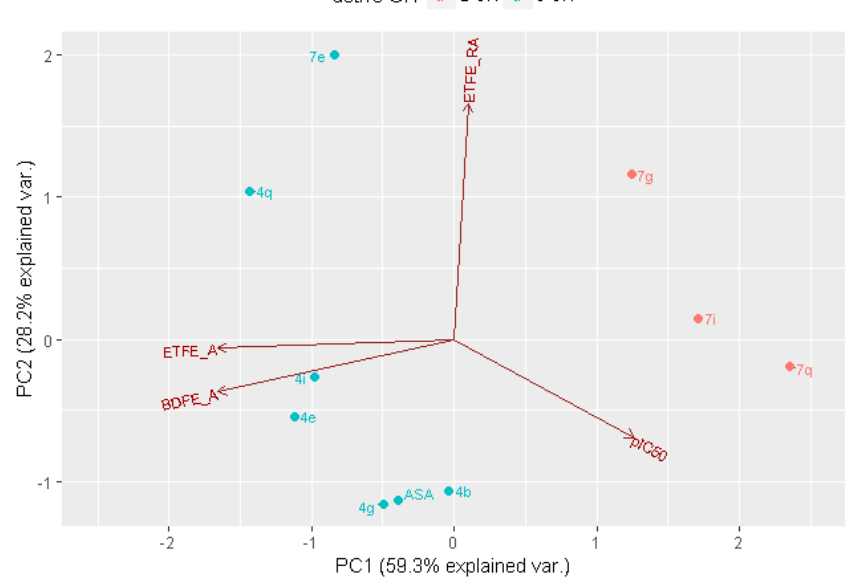
Figure 3. Principal component analysis (PCA) biplot for derivatives containing C4C5(OH) (series 4 ) or C4=C5 (series 7 ) fragments obtained by the PCA analysis performed in terms of the in vitro pIC 50 values and three significant in silico radical scavenging parameters (Table 2). For saturated / unsaturated derivatives, the more favorable parameter values for C3-O − / C2-O − anions have been used. The first two principal components explain 87.5% variance in the data set. Coloring is according to the active OH group in the 1st radical scavenging step. More active compounds have the higher pIC 50 values and are more on the right side of the plot.